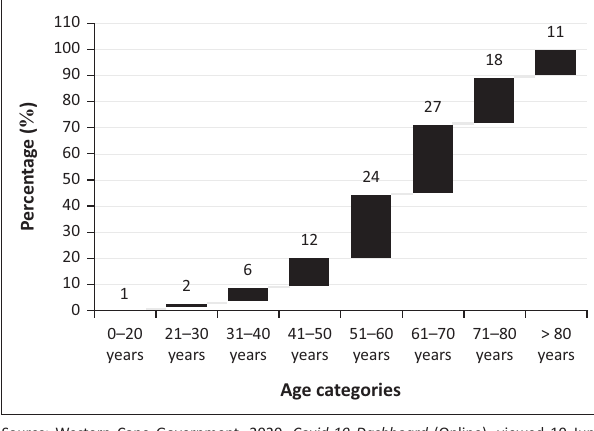
FIGURE 1: Distribution of COVID-19 deaths in the Western Cape by age category. Total deaths =